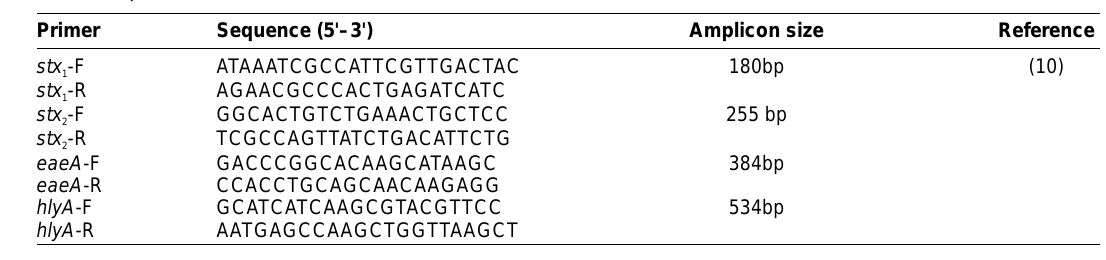
Table- 2. Occurrence of different virulence genes among the E. coli isolates from milk and milk products Types of